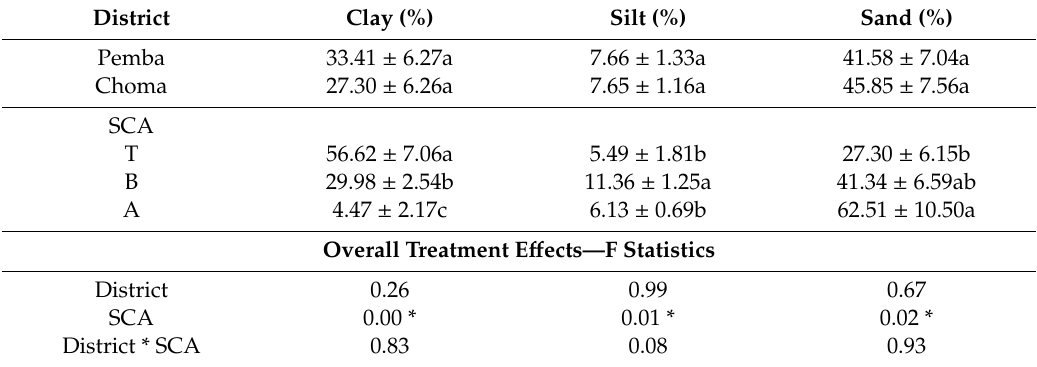
Table 4. Comparison of soil physical parameter values and treatment e ff ects across studied sites. District Clay (%)